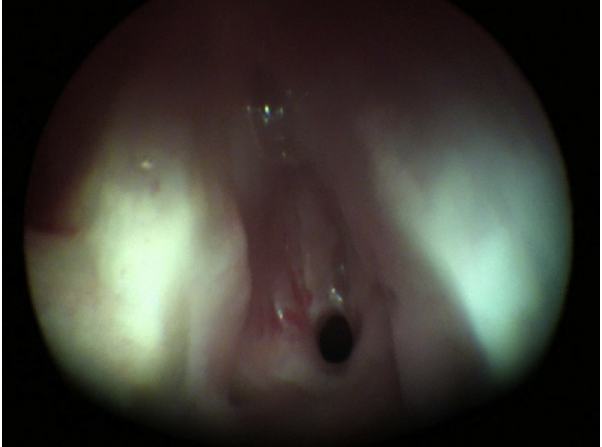
Figure 2 Chronic subglottic stenosis. Child with chronic grade III SGS, pre-dilatation.